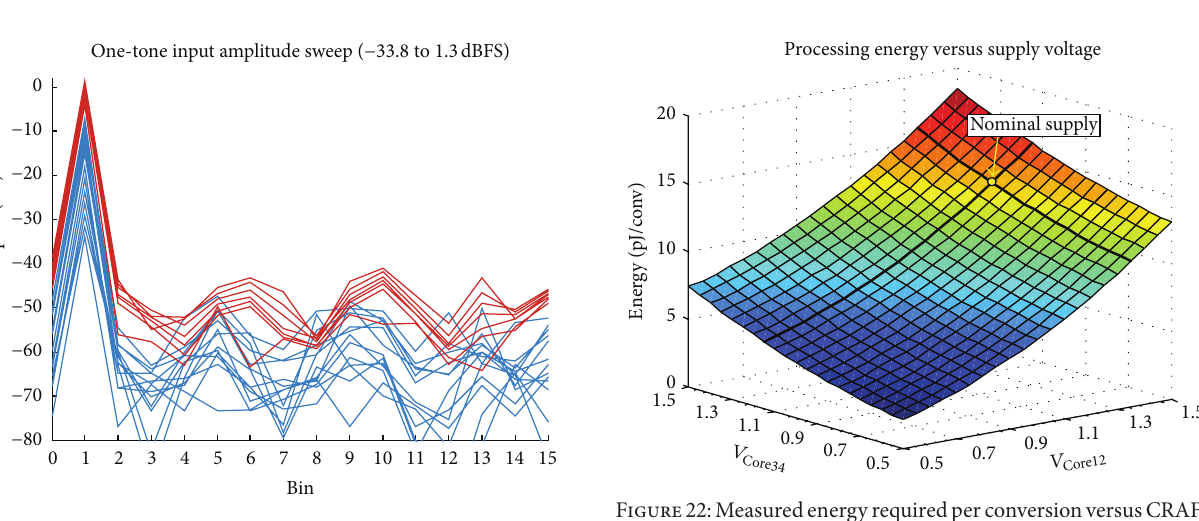
Figure22:MeasuredenergyrequiredperconversionversusCRAFT core supply